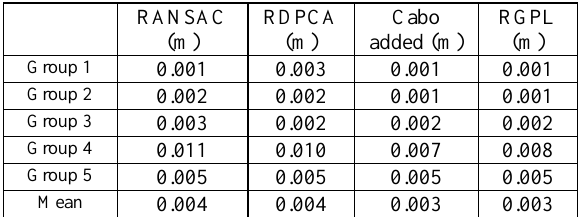
Table 11 RMSs after registration of four different approaches with all automatically extracted features